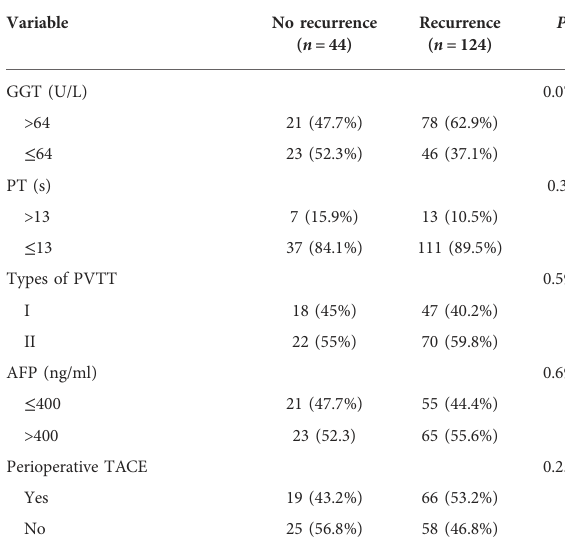
TABLE 1 Correlation of clinicopathological factors with tumor